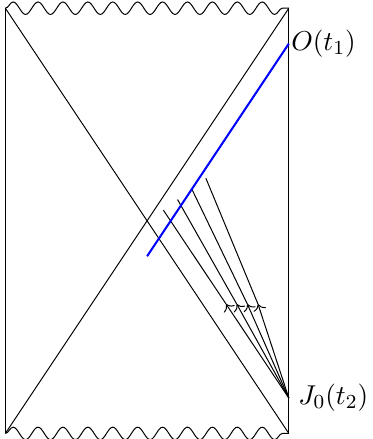
Figure 2 . Photon scatters with shockwave. The blue line denotes the shockwave sourced by scalar operator. The photon sourced by charge operator spreads in space-time. Classically, we can view it as a bunch of photons, with different longitudinal